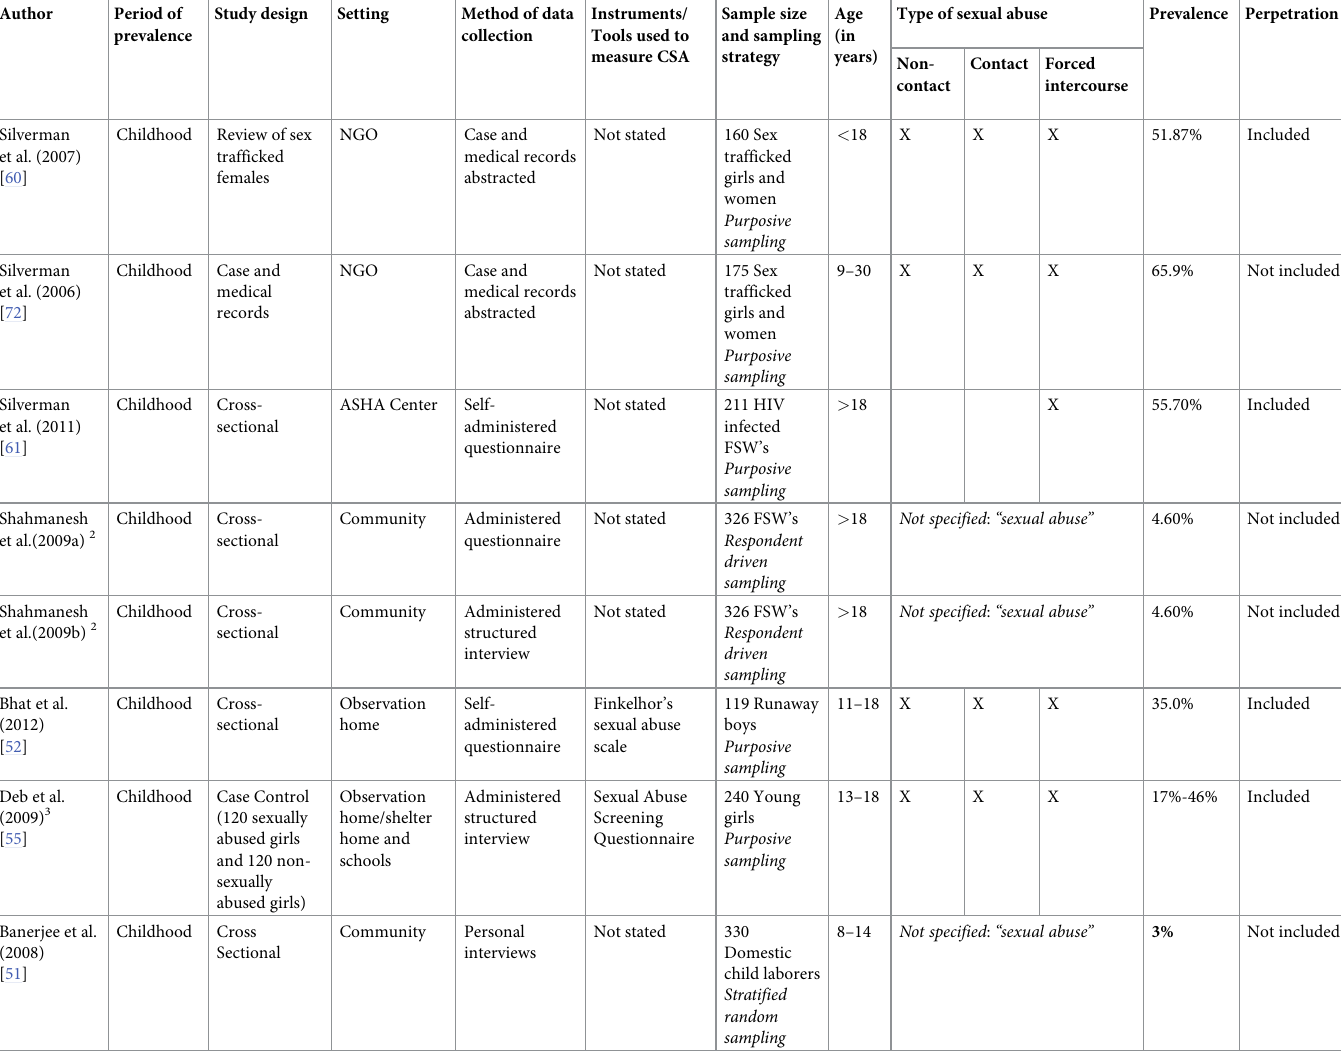
Table 6. Characteristics of quantitative and mixed-method studies included in the review with populations at